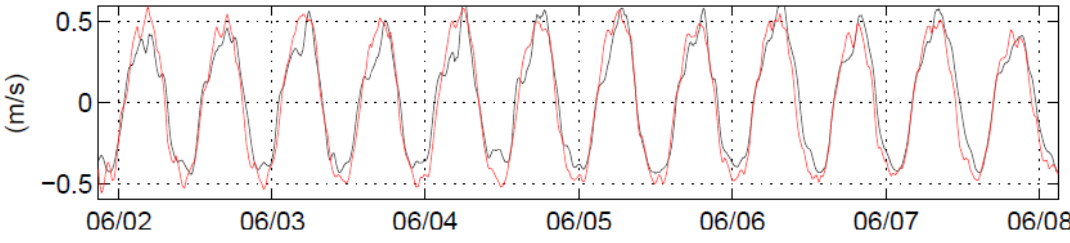
Figure 9. N-S tidal velocities comparison from 1 June to 9 June 2011 (red—simulated, black—measured) [31].